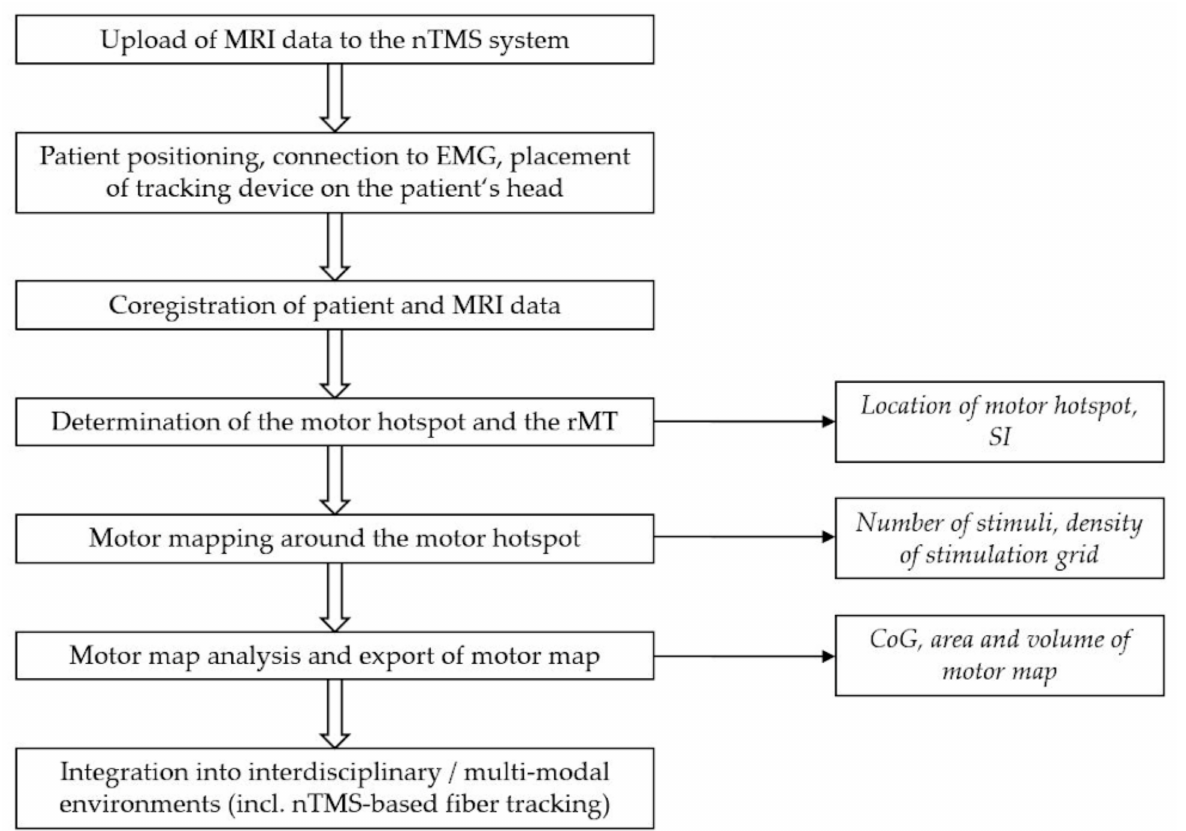
Figure 3. Overview of the main steps during the nTMS mapping procedure, starting with upload of the MRI data to the nTMS system and resulting in the generation of the individual motor map that can be further used for nTMS-based fiber tracking and other interdisciplinary or multi-modal applications. In addition, the main quantitative parameters that can be extracted from the single steps are shown (including the location of the motor hotspot, SI, number of stimuli, density of the stimulation grid, CoG, area, and volume of the motor